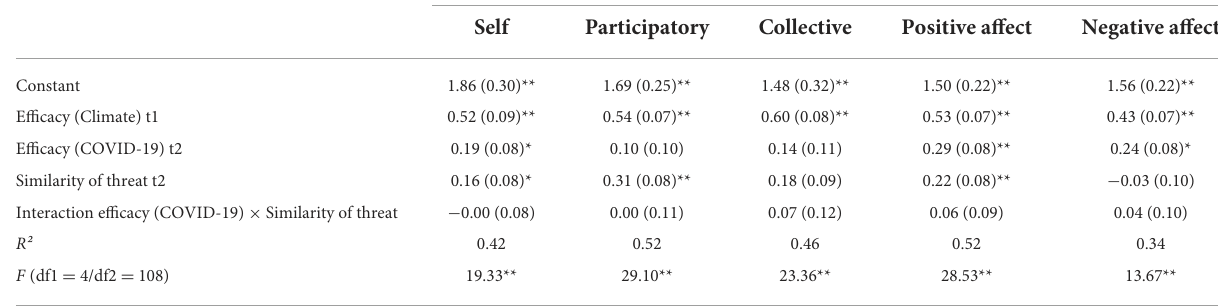
TABLE 3 Model coefficients for moderation models assuming a moderating effect of perceived similarity of threat on the transfer of COVID-19-related efficacy beliefs on climate-related efficacy beliefs. Predictor